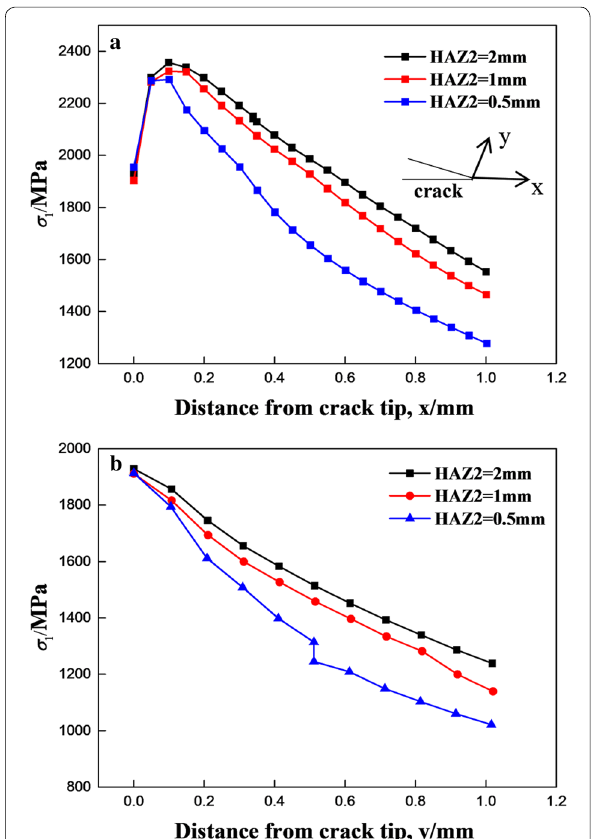
Figure 10 Effect of HAZ2 width on crack opening stress ahead of